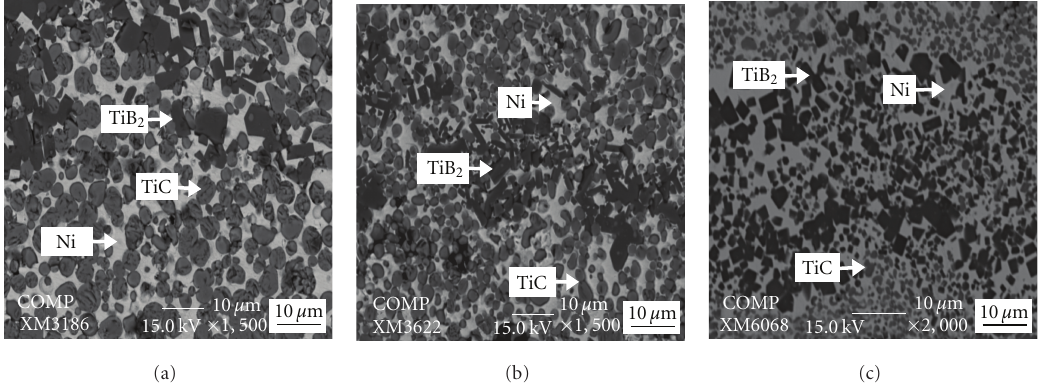
Figure 8: SEM photographs of samples with TiC/TiB 2 ratio of 3/1 and 20, 30, 40vol% Ni, respectively. (a) TiC-TiB 2 -Ni(60/20/20), (b) TiC-TiB 2 -Ni(52.5/17.5/30), and (c) TiC-TiB 2 -Ni(45/15/40).